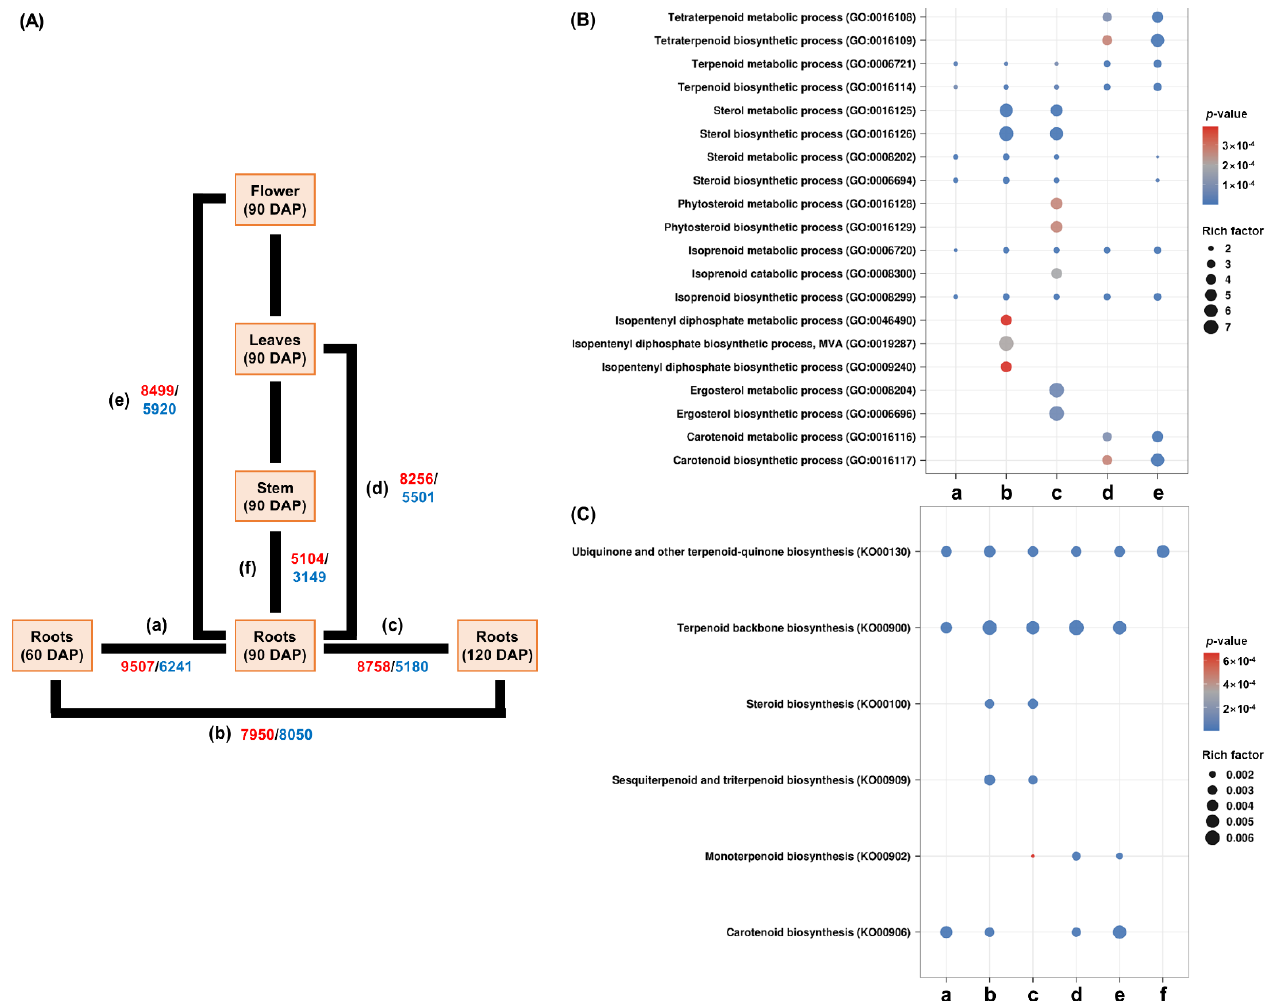
Figure 2. Analysis of GO and KEGG pathways. ( A ) Schematic diagram of DEG analysis. DEG anal ‐ ysis between roots’ development and other tissues using six comparative combinations: ( a ) 60 DAP roots vs. 90 DAP roots; ( b ) 60 DAP roots vs. 120 DAP roots; ( c ) 90 DAP roots vs. 120 DAP roots; ( d ) 90 DAP roots vs. 90 DAP leaves; ( e ) 90 DAP roots vs. 90 DAP flowers; and ( f ) 90 DAP roots vs. 90 DAP stems. Red and blue numbers indicate up- and down-regulated DEGs, respectively. ( B , C ) The analysis of terpenoid-related GO and KEGG terms using dot plot. The color of the circles represents the p -value between each comparison. The size of the circles indicates the DEGs ratio assigned to the GO or KEGG terms/all genes assigned to those GO or KEGG terms, respectively. DEGs , differentially expressed genes; GO , gene ontology; KEGG , Kyoto Encyclopedia of Genes and Genomes.